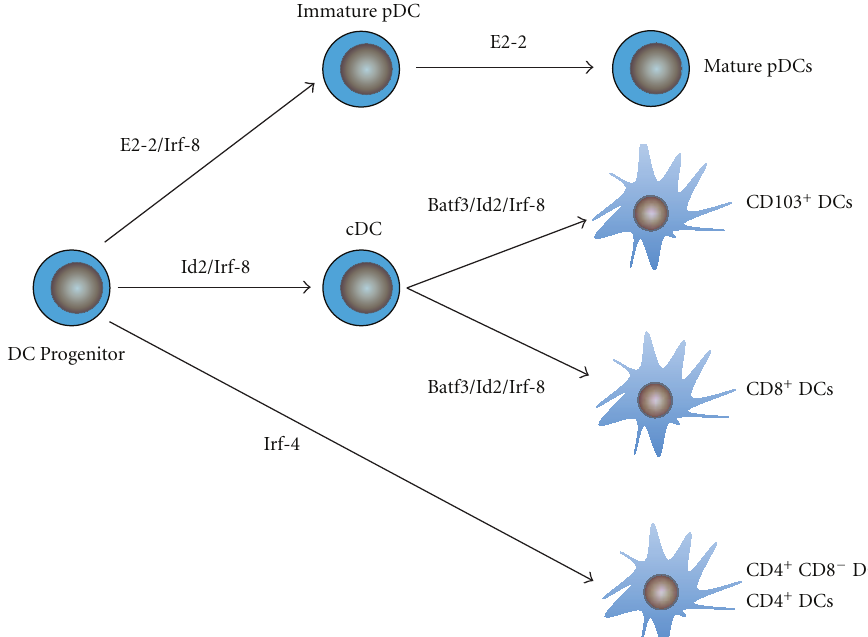
Figure 2: Transcription factors involved in DC development. Several transcription factors are required for the development of the common DC progenitor into functionally and phenotypically distinct subsets. IRF-8 is required for the development of both pDC and some cDC populations including the CD103 + and CD8 α + DC subsets. The bHLH protein E2-2 specifies the pDC lineage and is also required for the maintenance of mature pDC identity. During di ff erentiation, Id2 is induced in all conventional DC subsets and binds E2-2 to prevent their development into pDCs. The transcription factor Batf3 is essential for the development of CD103 + DCs; however, precursors of CD8 α + DCs can develop in its absence although their survival is impaired. Other DC (CD4 + and CD4 − CD8 − DCs) subsets depend more specifically on IRF-4 for their